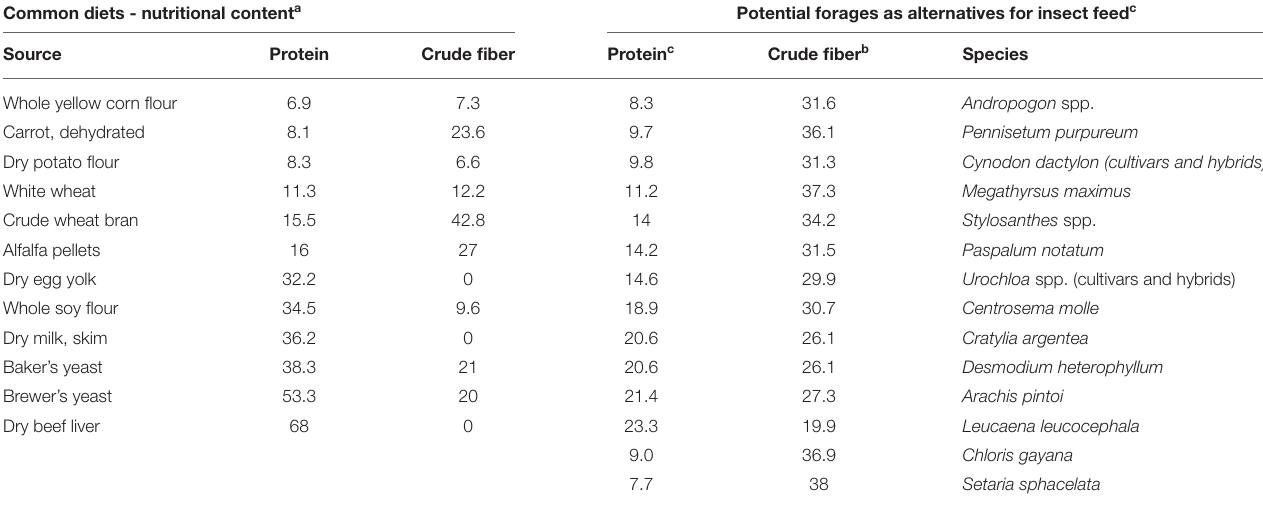
TABLE 2 | Content of common diets use in large-scale insect industry and potential forage species as alternatives for insect feed. Common diets - nutritional content a Potential forages as alternatives for insect feed